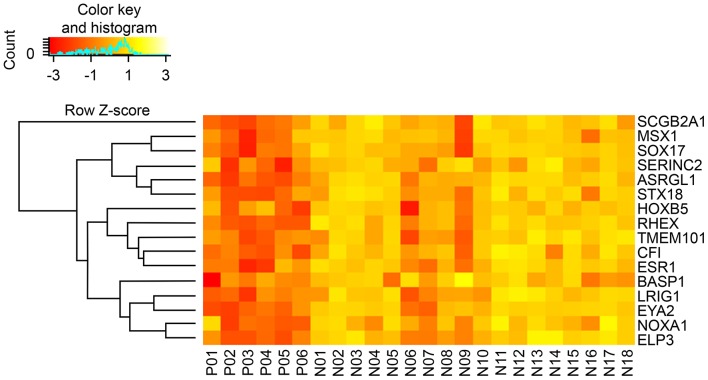
Hierarchical clustering heatmap of DEGs (rows) between LN (+) (P01–P06) and LN (–) (N01–N18) tumors. Yellow indicates high expression; orange indicates low expression.